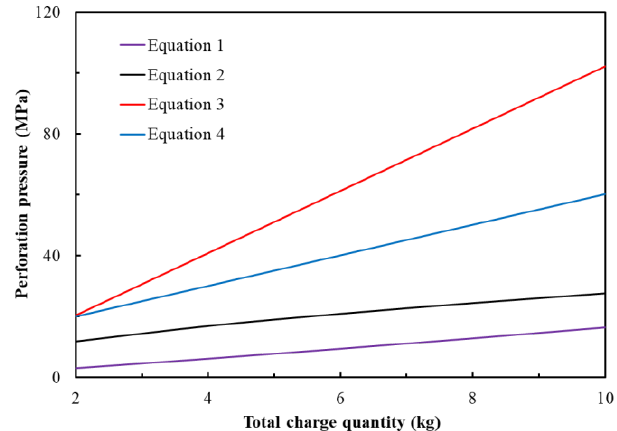
Figure 2. Calculation results from different empirical formulas.